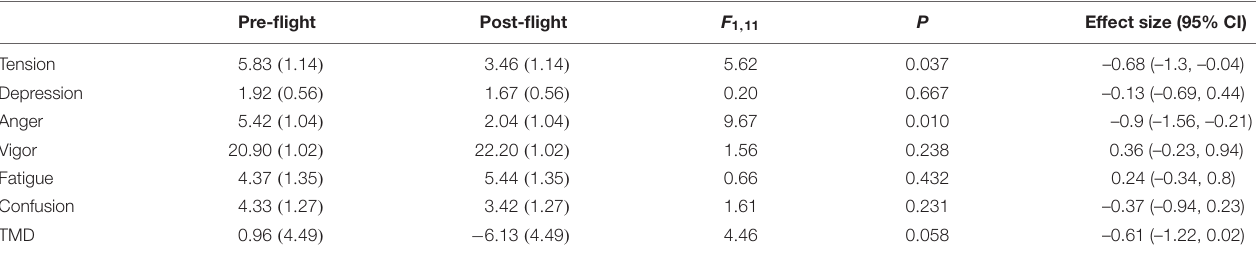
*Data represent marginal means and standard error in parentheses. TMD, Total Mood Disturbance, F, F-statistics; P, p-value; Effect size is Cohen’s d in 95% confidence intervals (95% CI).